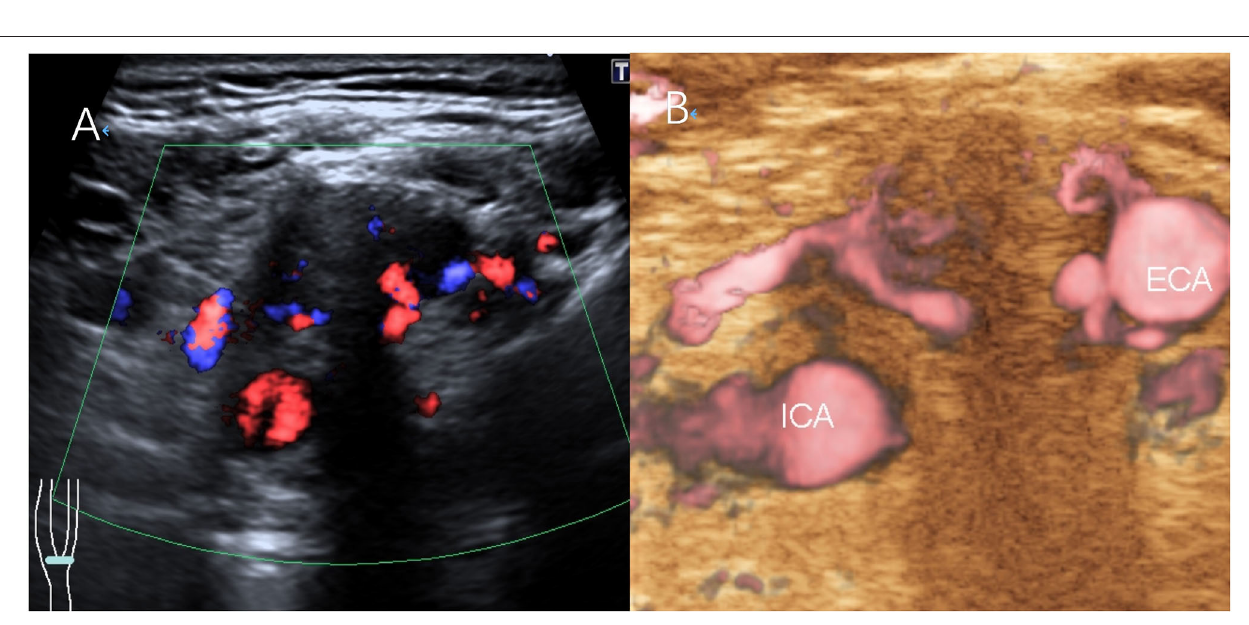
from the ECA and ICA. Catheter angiography confirmed that the vascular supply to the CBT arose